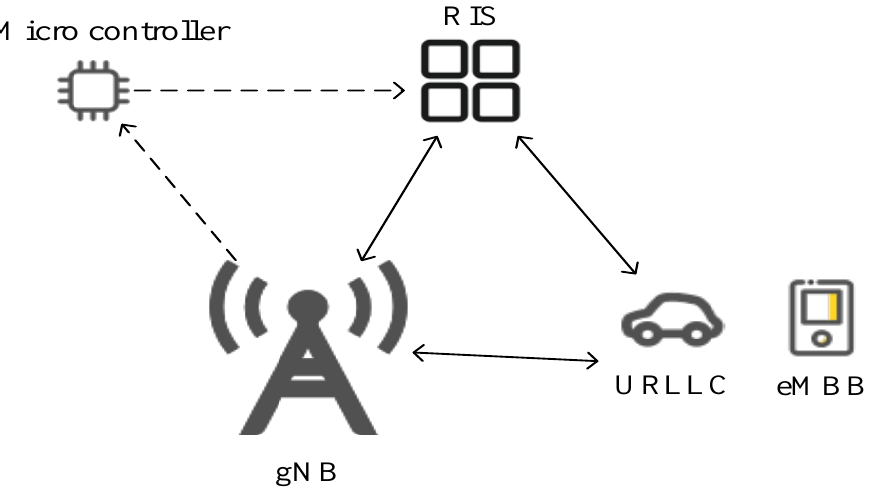
Figure 1. System Model for eMBB and URLLC Coexistence Services.